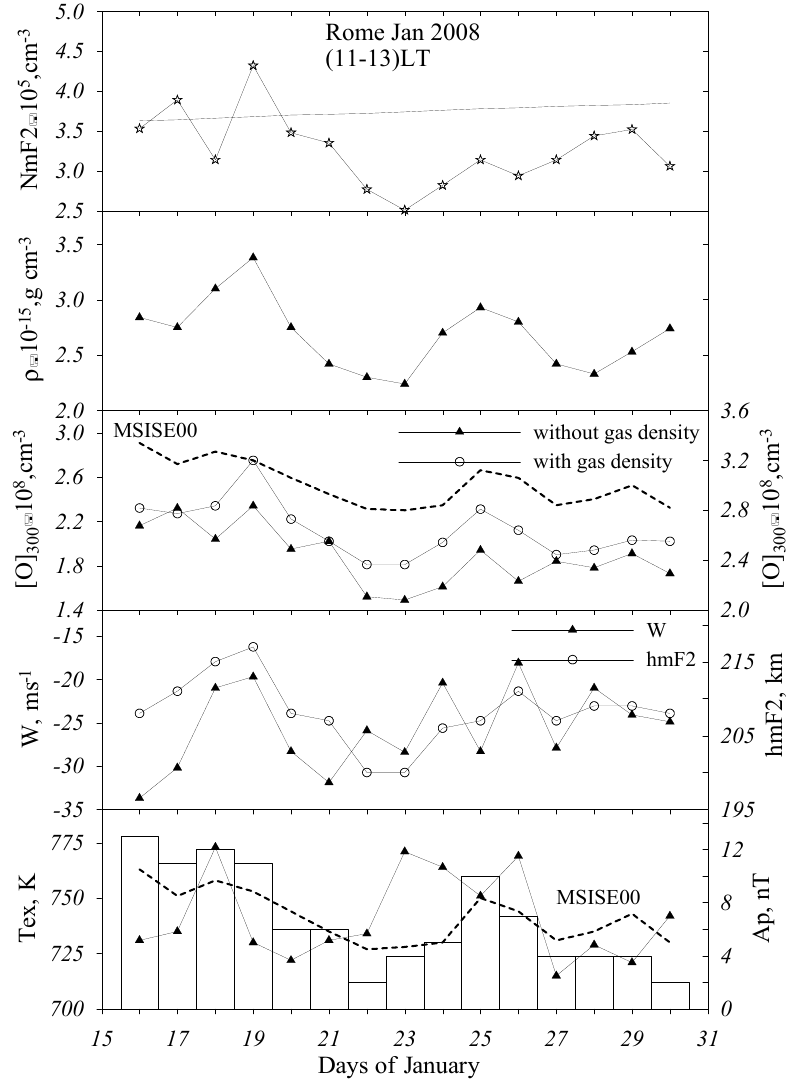
Figure 7. Same as Figure 4 but for the January 2008 SSW